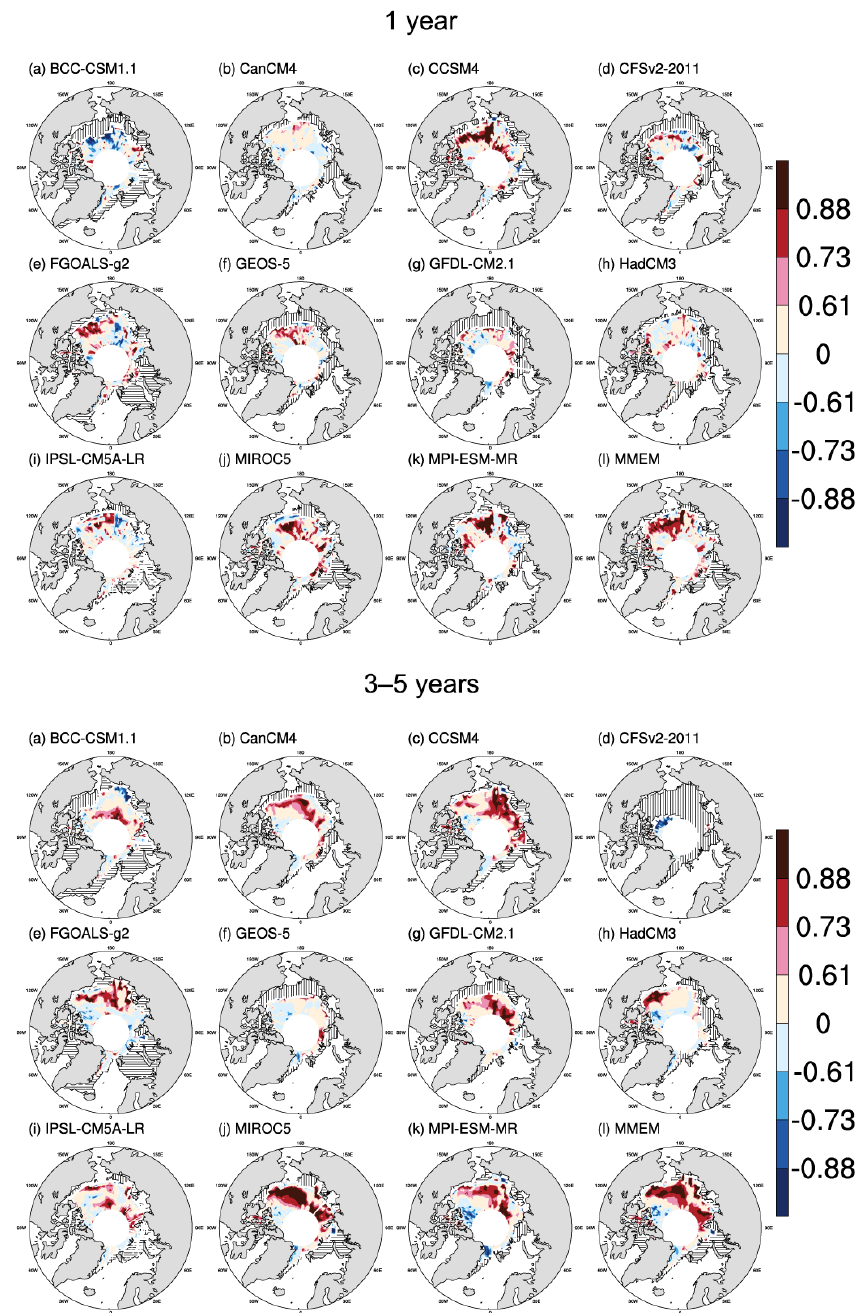
Figure 3. Anomaly correlation coefficients between the simulated and observed Arctic September sea ice concentration anomalies for the lead time of 1 year (top panel) and 3–5 years (bottom panel). The correlation coefficients of 0.61, 0.73, and 0.88 represent 90, 95, and 99% confidence levels, respectively. Horizontal lines depict the areas where the model simulation has sea ice, whereas the observation does not have sea ice. The opposite is the case for vertical